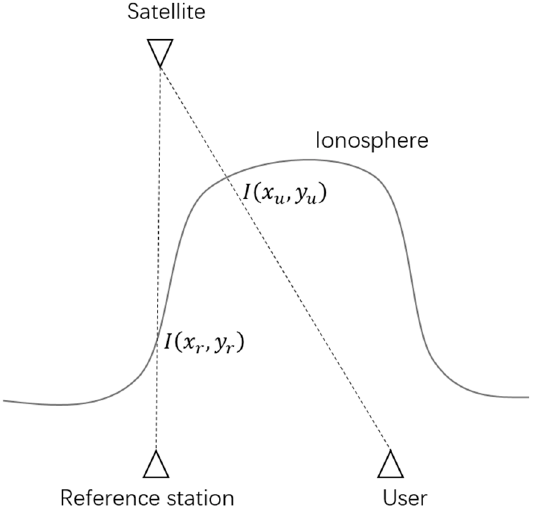
Figure 1. Effects of differential ionospheric delay on differential global navigation satellite system (DGNSS) performance.